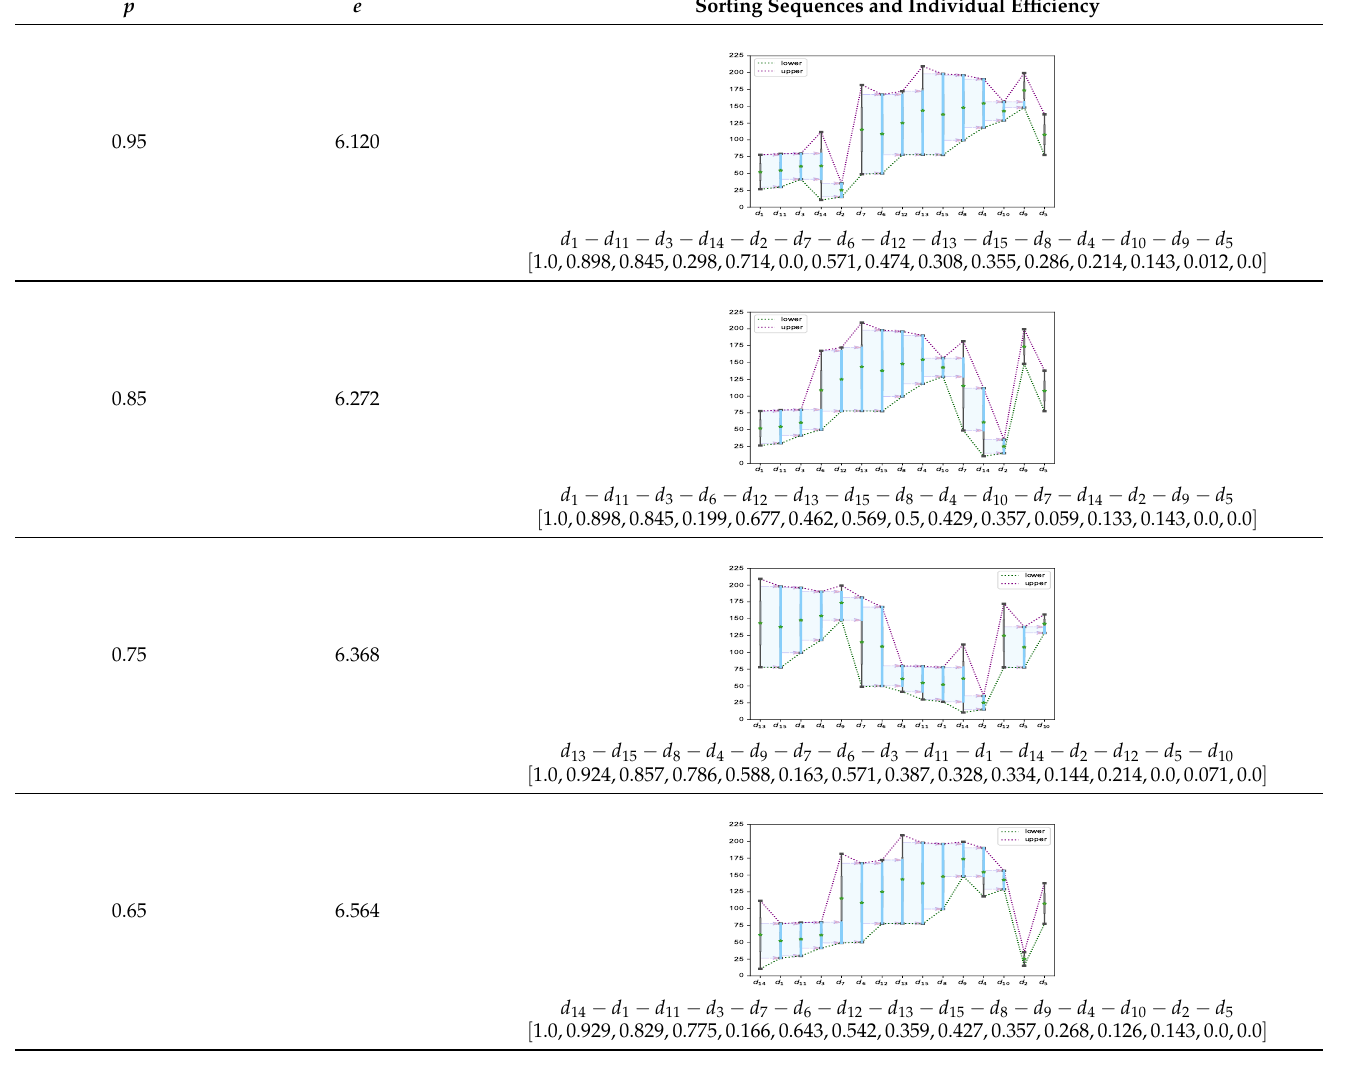
Table A4. Solutions of sorted negotiation Model (19) for different p ( o (cid:48) ∼ U ( 10,210 ) , B 0 = 4000). p e Sorting Sequences and Individual Efficiency